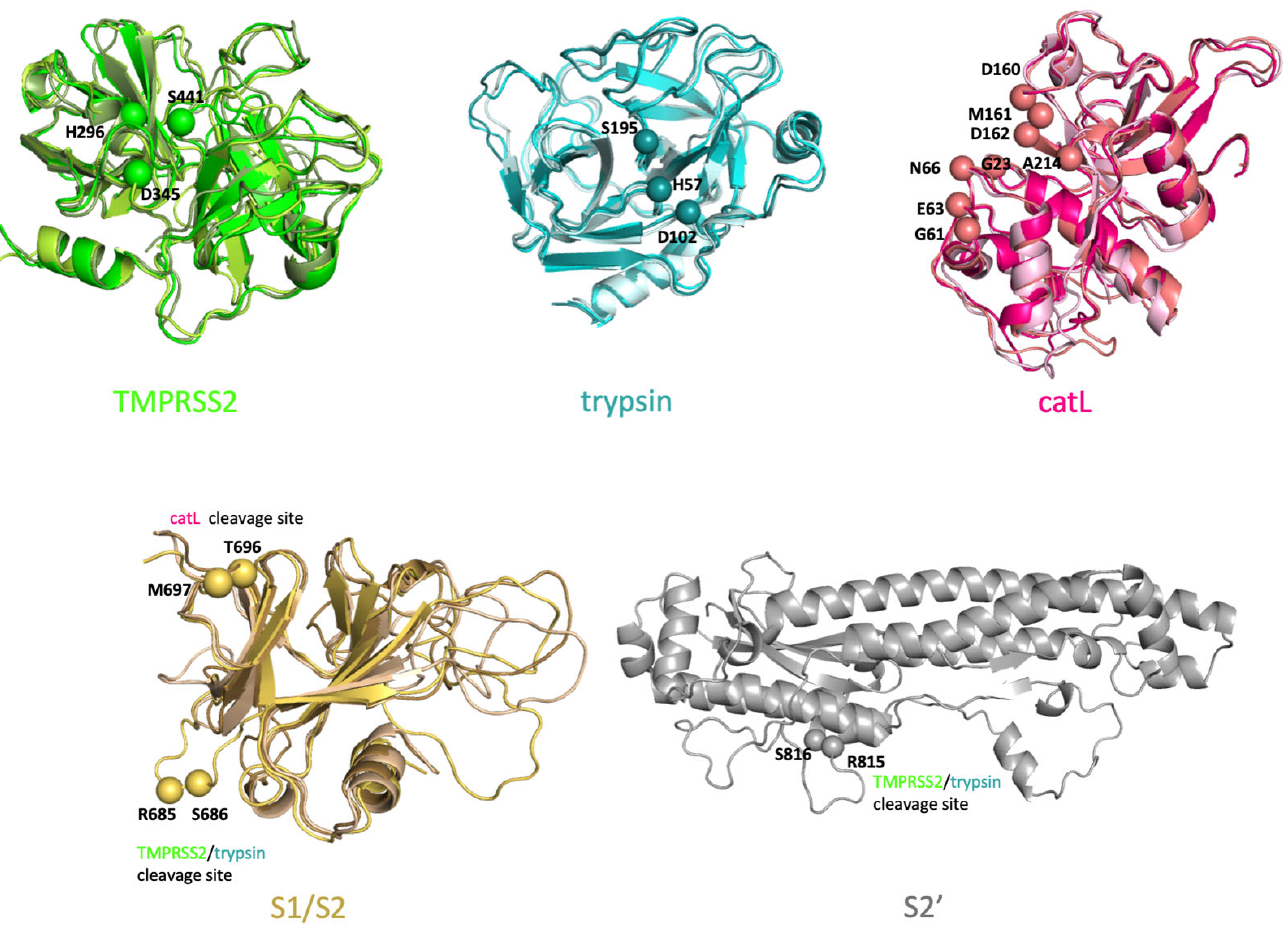
Figure 2. Ensembles of configurations of unbound proteases and spike (S) protein cleavage sites. Three configurations for TMPRSS2, trypsin, catL and S1/S2, as well as one configuration for S2’, were used for in silico screening. The catalytic residues on TMPRSS2, trypsin and catL, as well as the cleavage sites of S protein structures, were labeled, and C α atoms of the residues were represented with